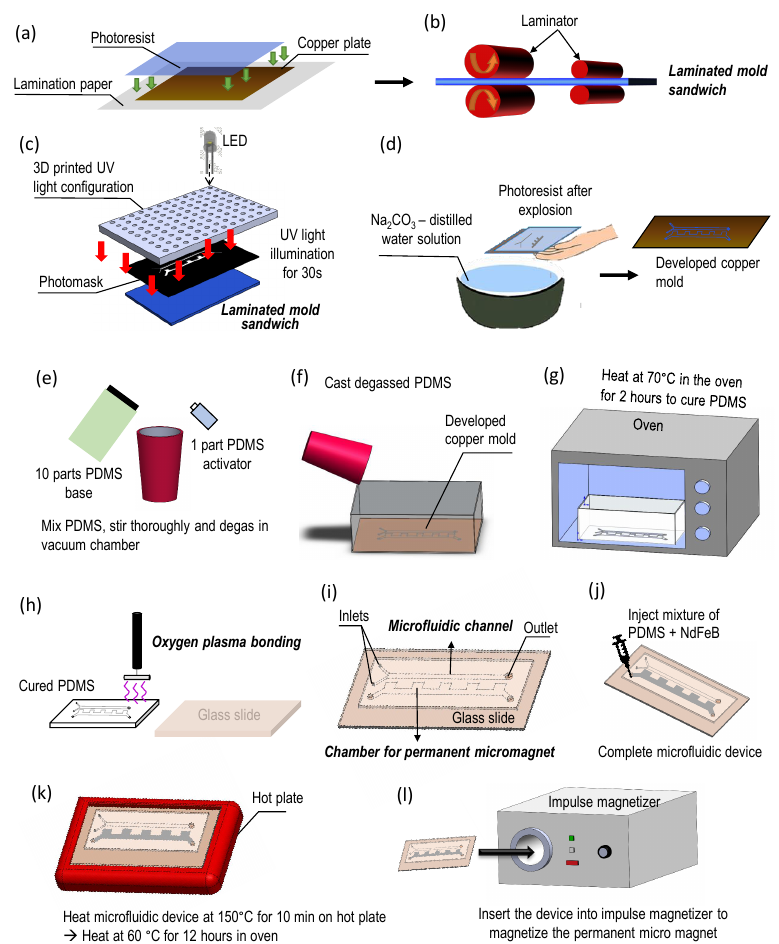
Figure 2. Fabrication steps of the micromixing device with embedded micromagnet. ( a ) A photoresist film, 2 in × 3 in copper plate, and lamination paper are sandwiched together. This configuration will be called “mold sandwich”. ( b ) The mold sandwich is run through a laminator at 100 ◦ C for four times. ( c ) A photomask is placed on the laminated mold sandwich and it is illuminated by custom-made UV light for 30 s. ( d ) The exposed layer of copper plate and photoresist film are developed in a solution of 10 g sodium carbonate powders and 1 L of distilled water for 60 s. ( e ) In a plastic cup, 10 parts of polydimethylsiloxane (PDMS) base and 1 part PDMS activator are mixed together and degassed in a vacuum chamber. ( f ) While the PDMS is degassing, the developed copper plate is placed inside an aluminum box. Once the PDMS solution is totally degassed, it is cast into the aluminum box that contains the copper mold. ( g ) The box with copper mold and liquid PDMS is heated in the oven at 70 ◦ C for 2 h. ( h ) Once the PDMS is cured and cooled down, holes are drilled at the inlets and outlet of the device. A glass slide and the cured PDMS are cleaned thoroughly using isopropanol (IPA) and distilled water. The PDMS and glass slide are then bonded together using oxygen plasma and left on a hot plate at a temperature of 120 ◦ C for 12 h. ( i ) The microfluidic device consisting of channels and chamber for microscale magnet is ready. ( j ) A mixture of neodymium powders and PDMS is injected into the chamber. ( k ) The NdFeB and PDMS mixture is cured on a hot plate and subsequently in the oven. ( l ) The device is inserted into an impulse magnetizer to magnetize the NdFeB-PDMS mixture as a permanent microscale